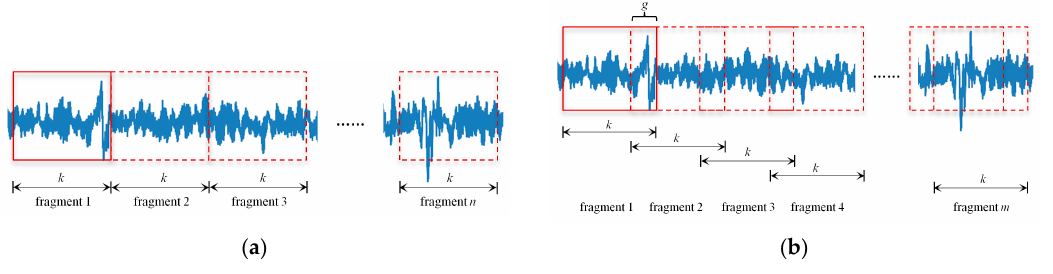
Figure 6. Data augmentation of ( a ) common means and ( b ) adopted operation.